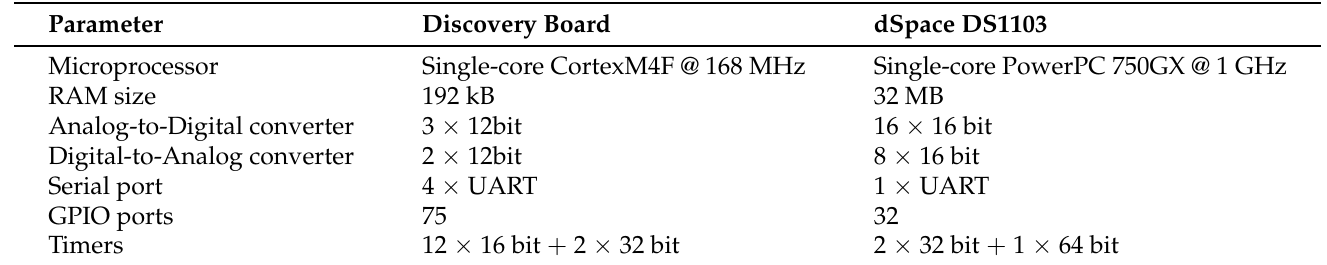
Table 1. Comparison of the chosen parameters of the laboratory hardware and the low-cost